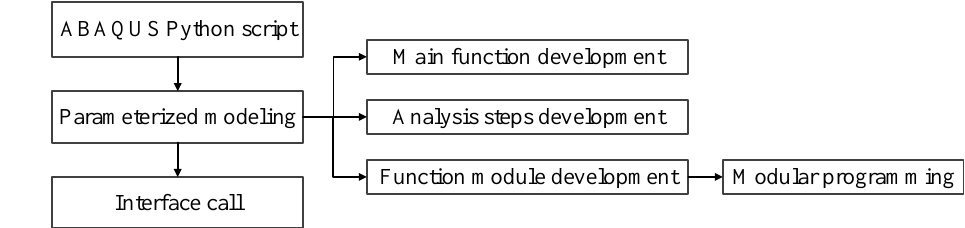
Figure 4. The parameterized modeling process.